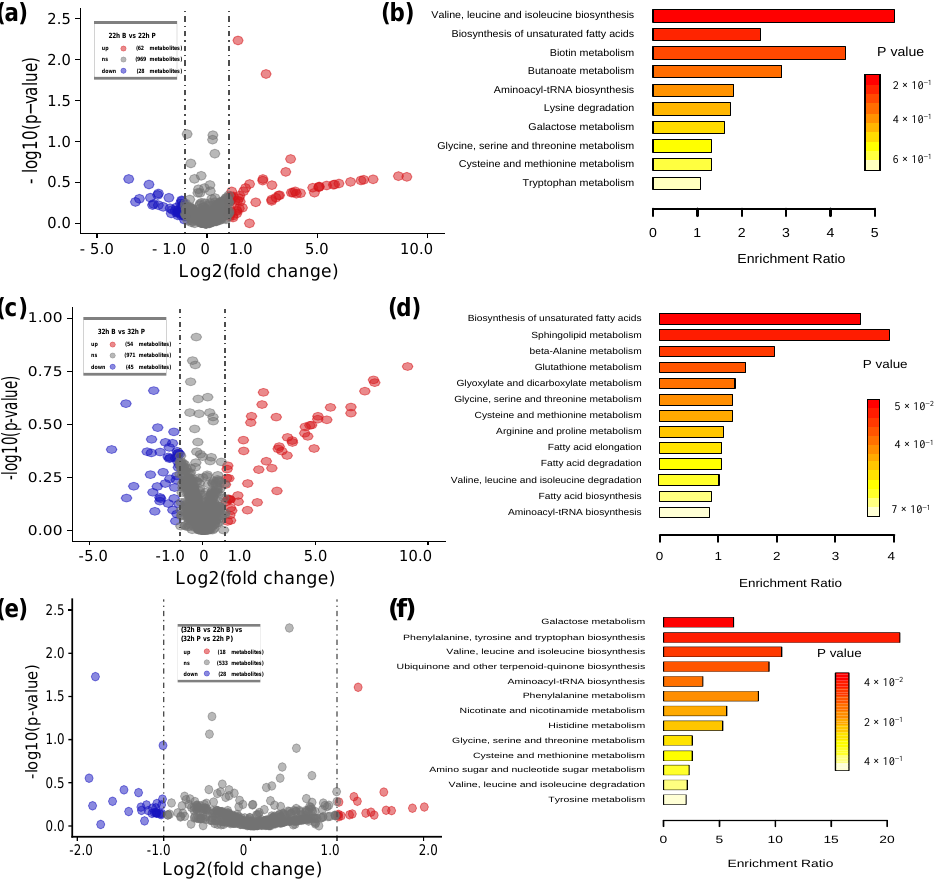
Figure 6. Metabolite profiling changes and enrichment pathway analysis during biofilm formation. The volcano plot showing the upregulated (red points) and downregulated (blue points) metabolites ( a ) and enrichment pathway analysis of these metabolites ( b ) between 22 h B and 22 h P. The volcano plot showing the upregulated and downregulated metabolites ( c ) and enrichment pathway analysis of these metabolites ( d ) between 32 h B and 32 h P. The volcano plot showing the upregulated and downregulated metabolites ( e ) and enrichment pathway analysis of these metabolites ( f ) between 32 h B vs. 22 h B and 32 h P vs. 22 h P (22–32 h was the biofilm growth